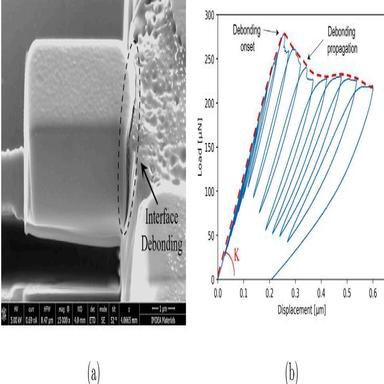
Mode I test specimen with interface debonding highlighted (a) and the respective load-displacement curve (b). The red dashed line in (b) shows load displacement under continuously increased applied displacement.